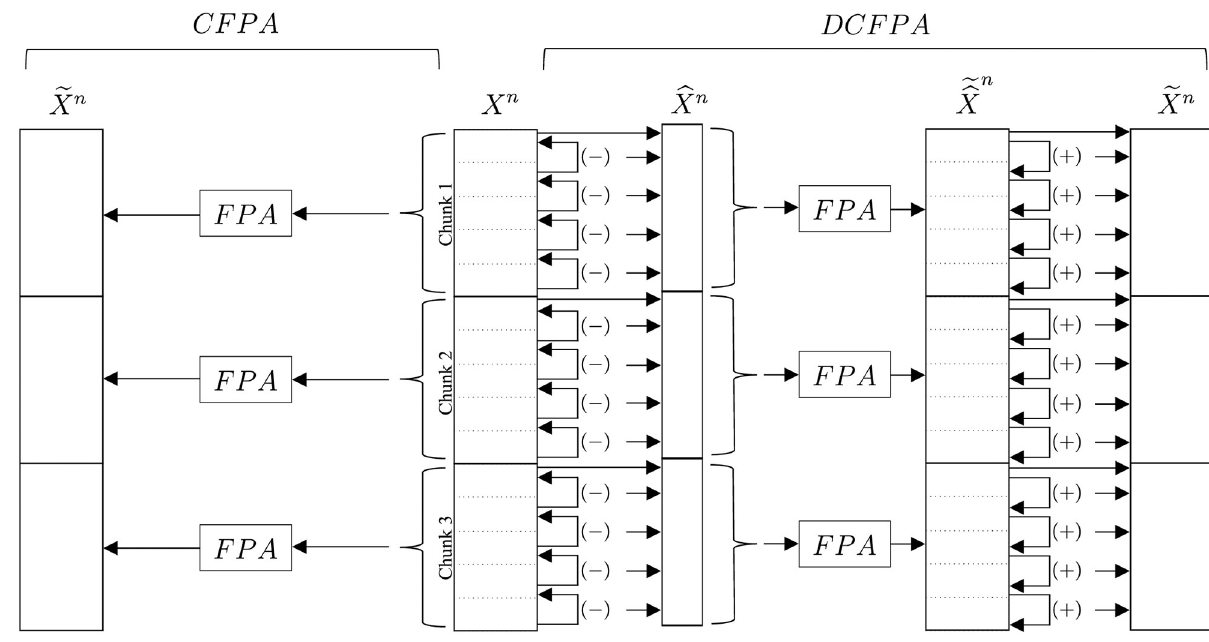
Fig 2. Flow of the CFPA and